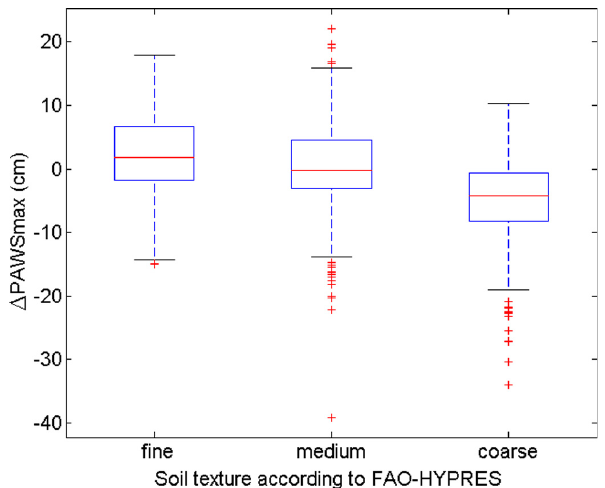
Fig. 5. Ternary diagram of the soil texture triangle showing markers whose color depends on the magnitude of variable 1 PAWS max be- ing the difference between the maximum plant-available soil-water holding capacity when field capacity is alternatively determined us- ing the drain - or fix -method.